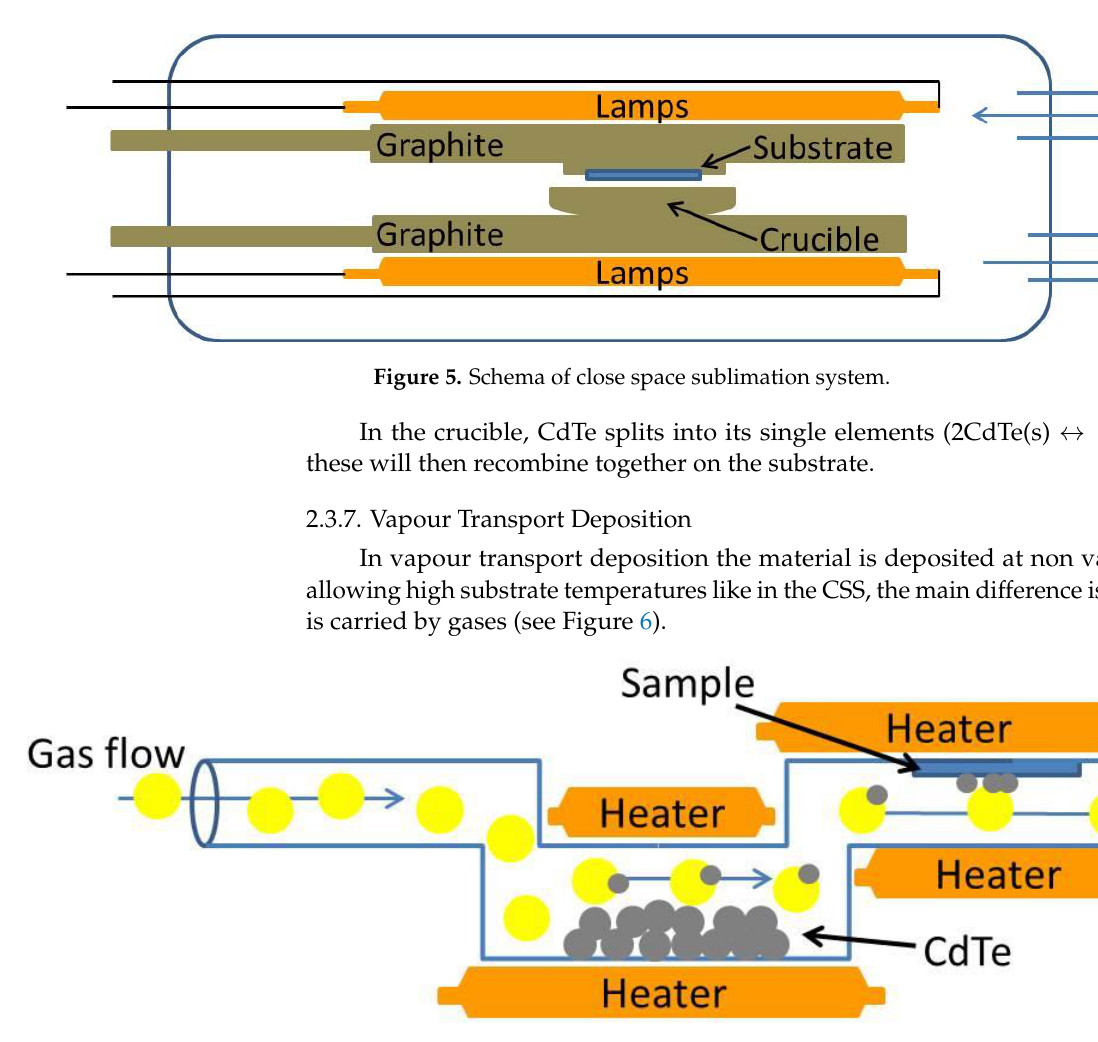
Figure 6. Schema of vapour transport deposition system.